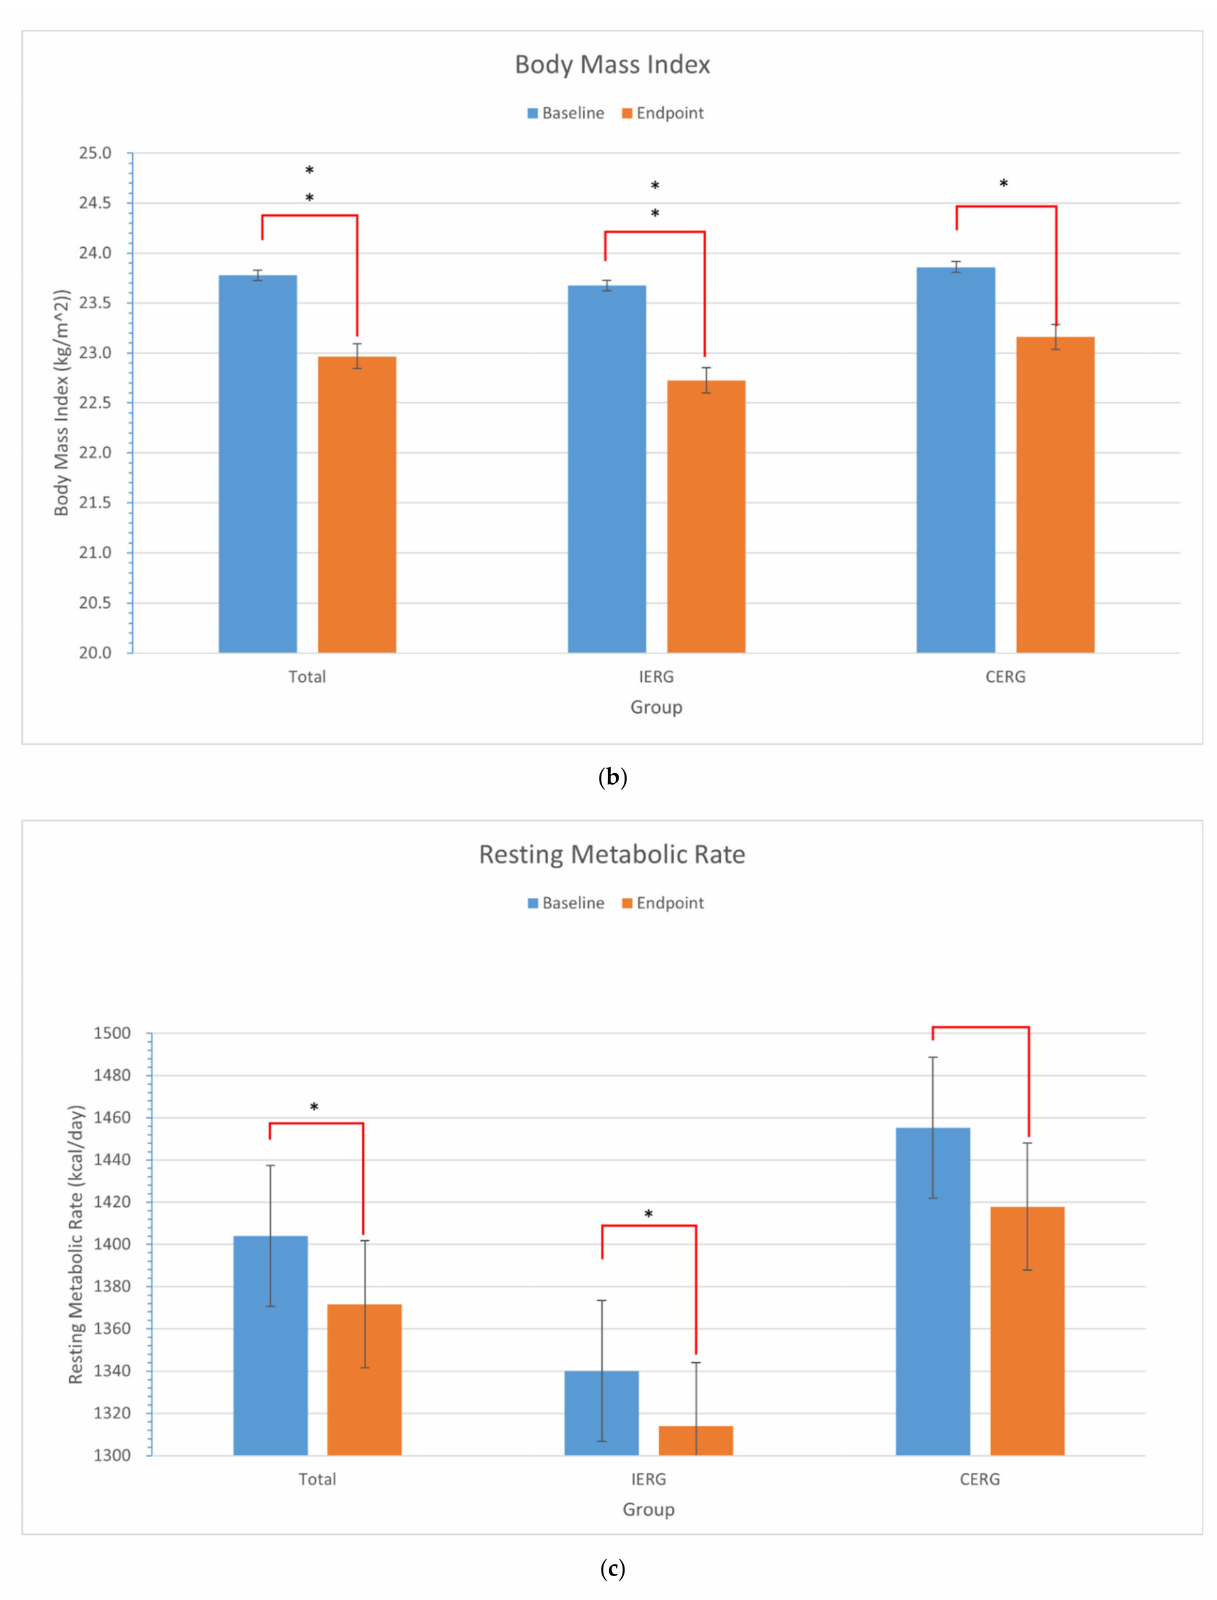
Figure 3. Changes and the difference in bodyweight, BMI, and RMR within and between groups. ( a ) the changes of bodyweight within groups; ( b ) the changes of BMI within groups; ( c ) the changes of RMR within groups. *: p <